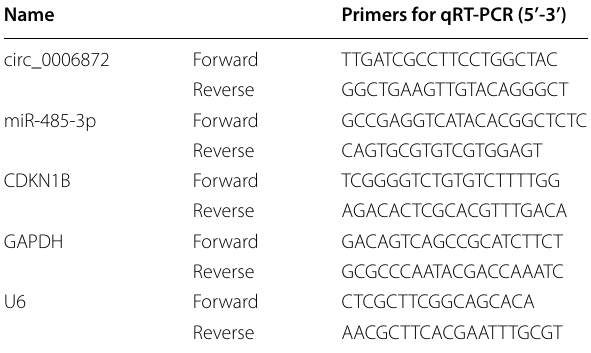
Table 1 Primers sequences used for